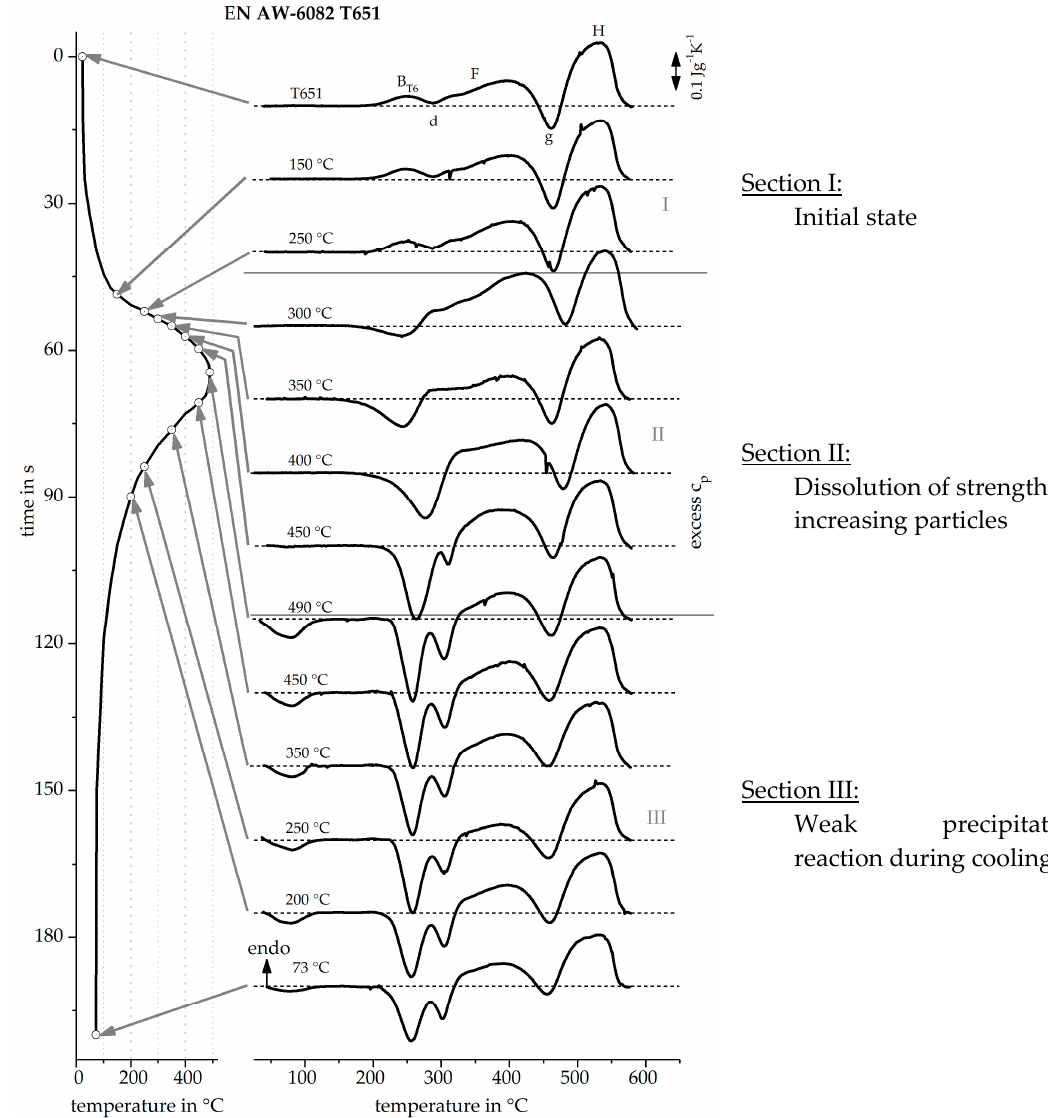
Figure 18. Reheating curves of the alloy EN AW-6082 T651 after heating like in the heat affected zone caused by an arc welding.